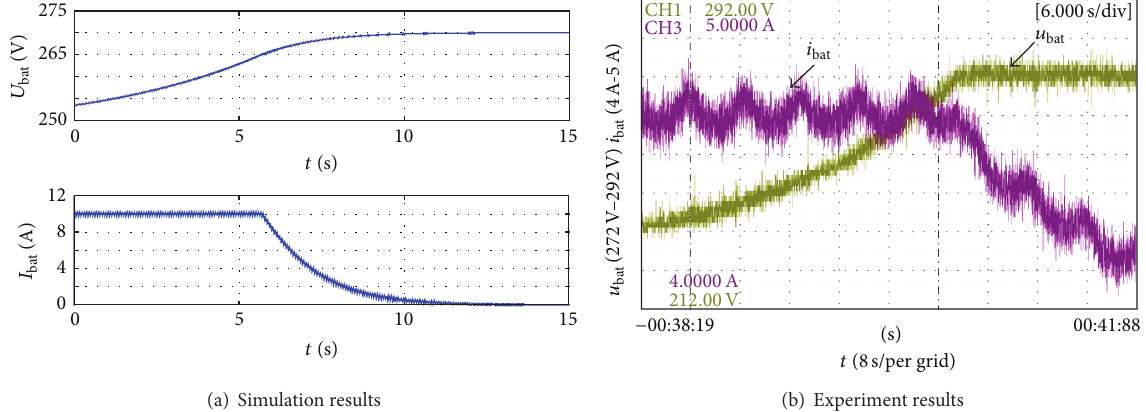
Figure 13: Results of constant-voltage current-limiting charge method.